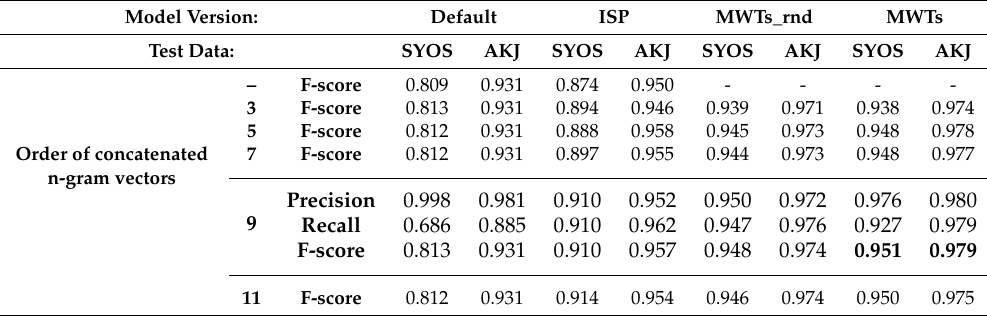
Table 8. Evaluation results—Universal Segmenter (best results in bold).